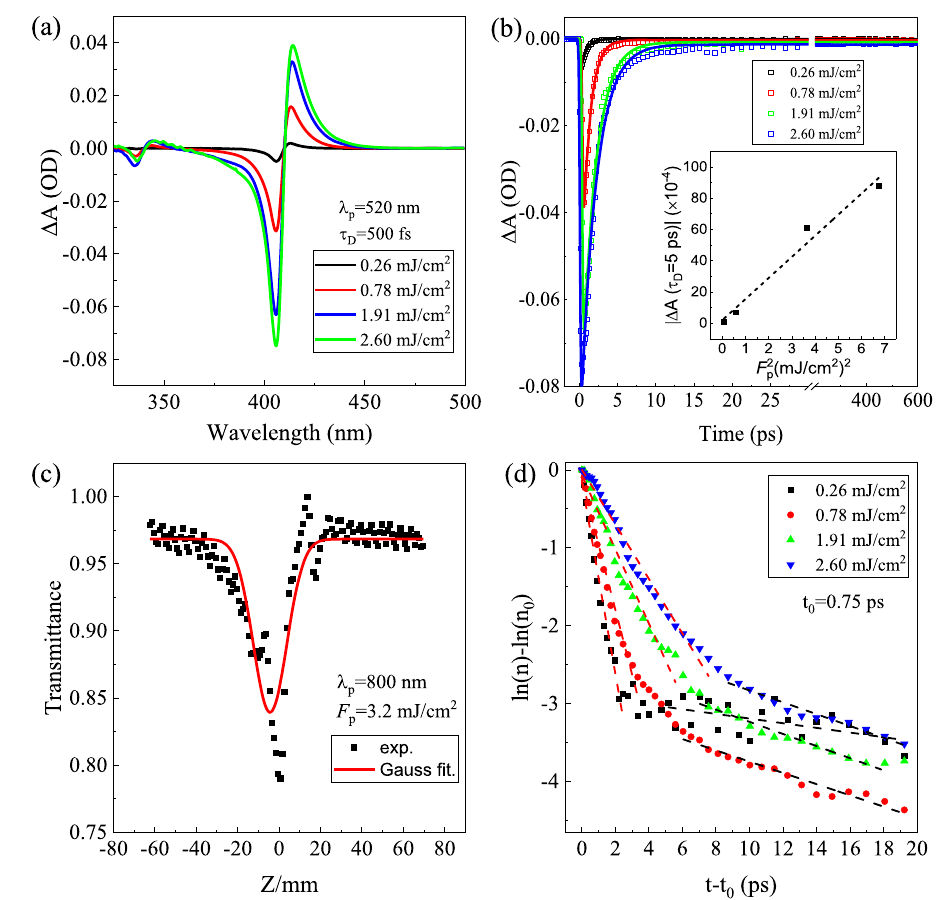
Fig. 8 | Ultrafast carrierdynamicsin two-photon absorption.a TAspectraofas- grown CuI thin fi lm under different pump fl uences at a time delay of 0.5ps with λ p =520nm, and b corresponding kinetic traces at 406nm with the best (solid line). Inset in b shows the measured | Δ A| signal (recorded at 5ps) with